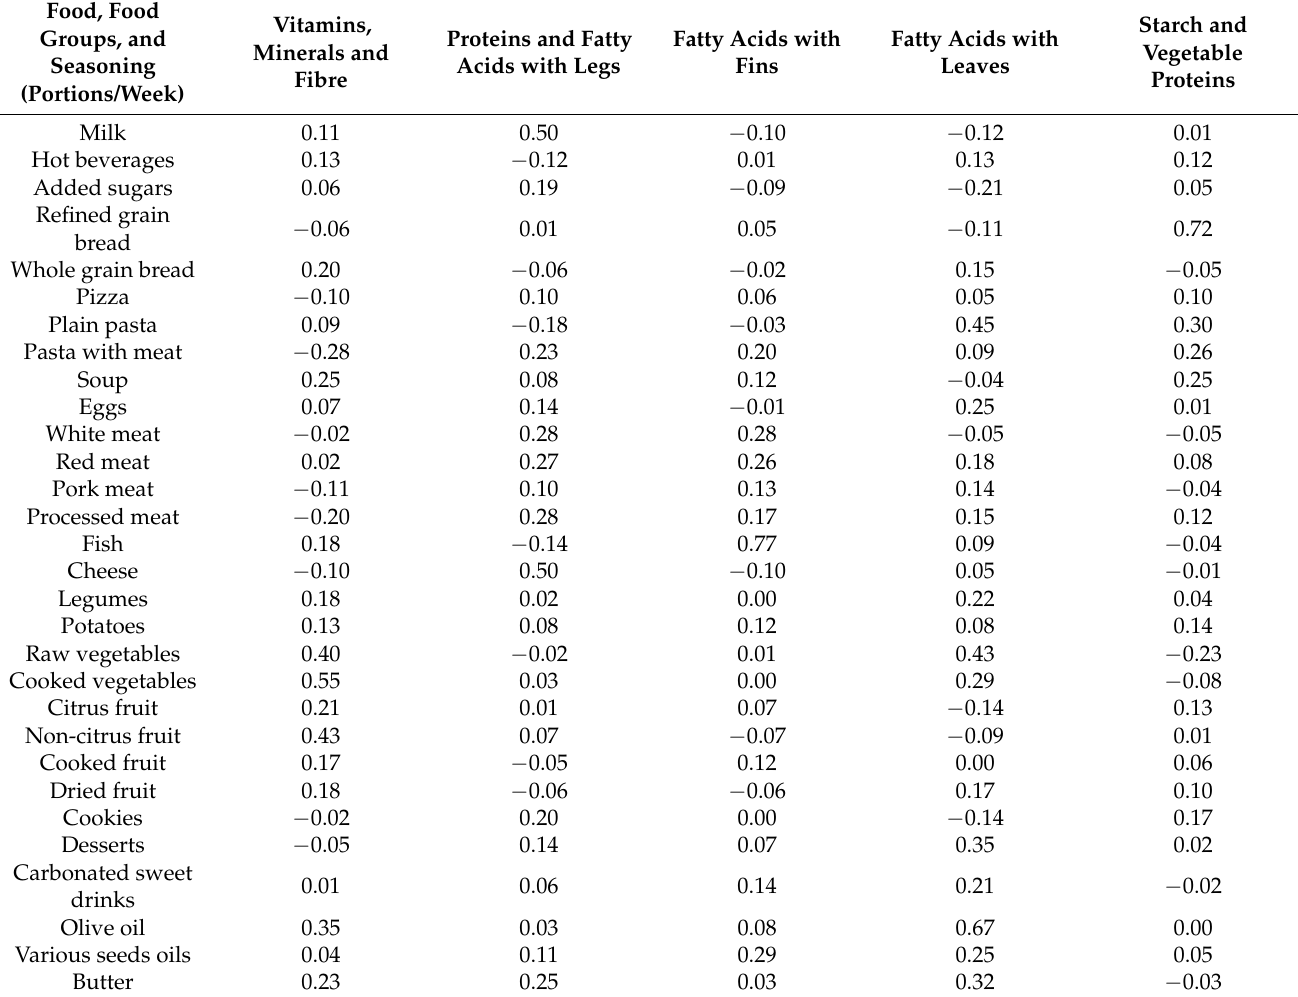
Table 2. Spearman rank correlation coefficients between maternal factor scores derived from principal component factor analysis (PCFA) and weekly number of portions of selected food, food groups and seasonings derived on the same data. Italy,